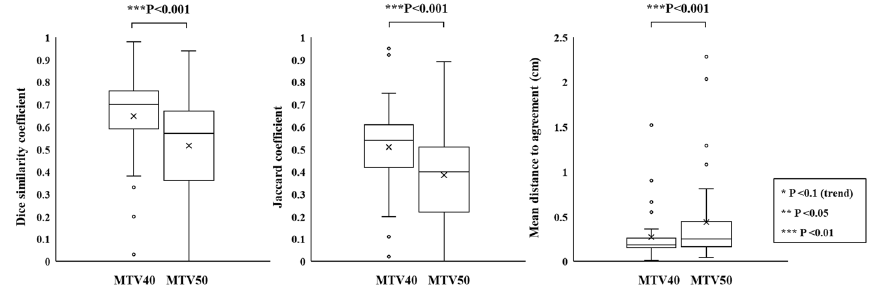
Fig. 11 The volume ratio of MTV40 and MTV50 to GTV between 18 F-FDG and 18 F-BPA PET for all patients